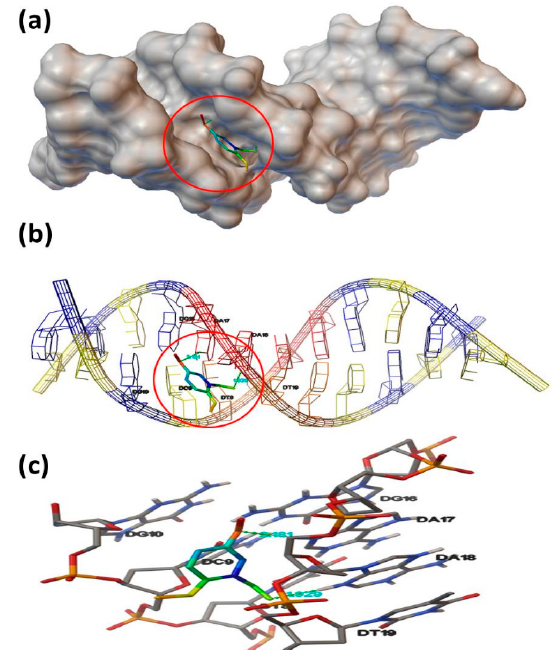
Figure 12. ( a ) Schematic representation of the binding position of the endo -isomer to DNA. ( b ) Interactions of the endo -isomer with the nuclides of the one DNA helix. ( c ) Nuclides-Z-isomer positional binding and hydrogen-bonding interactions of the exo -isomer with DNA adenosines (DA17: H ∙∙∙ OMe and DA18: H ∙∙∙ O=C).